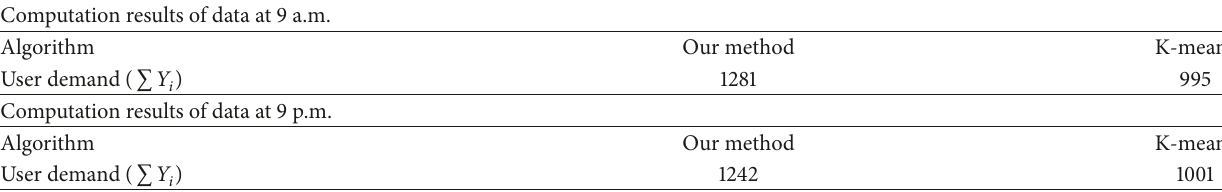
Table 6: Computation results of different